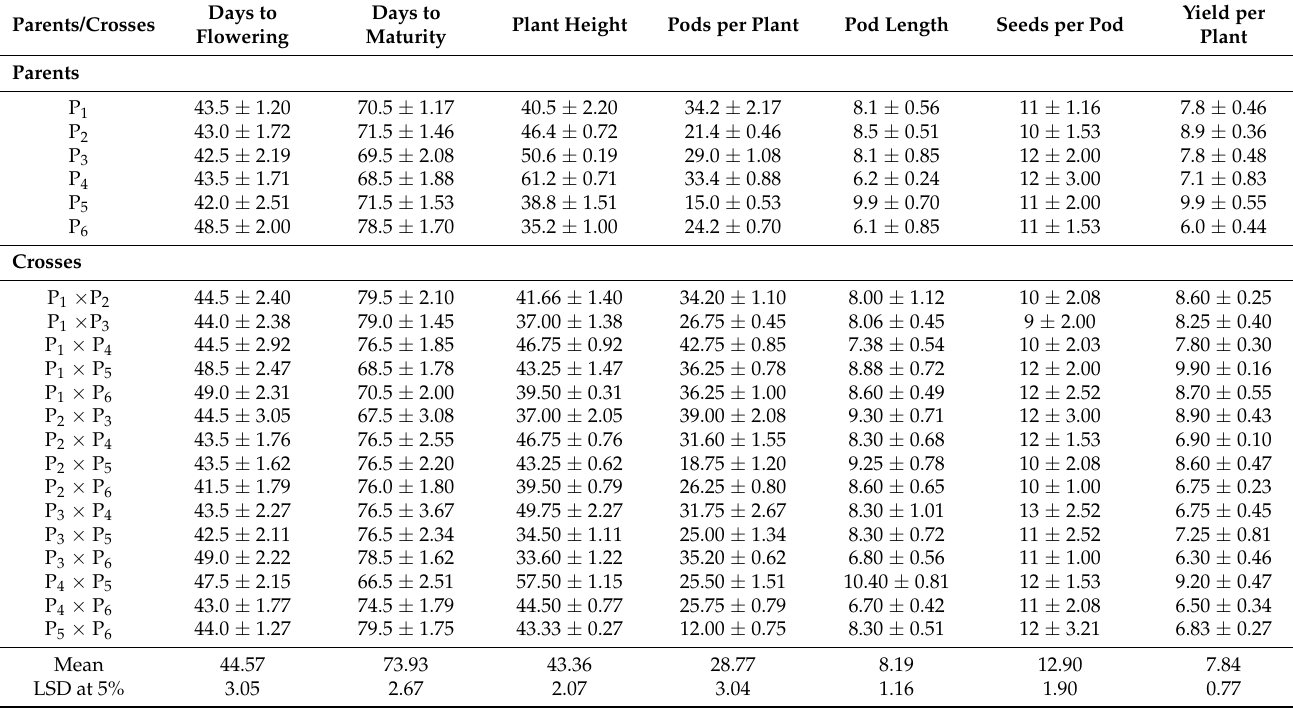
Table 2. Mean ± standard deviation (sd) of days to flowering, days to maturity, plant height, pods per plant, pod length, seeds per pod, and yield per plant of parents and their F 1